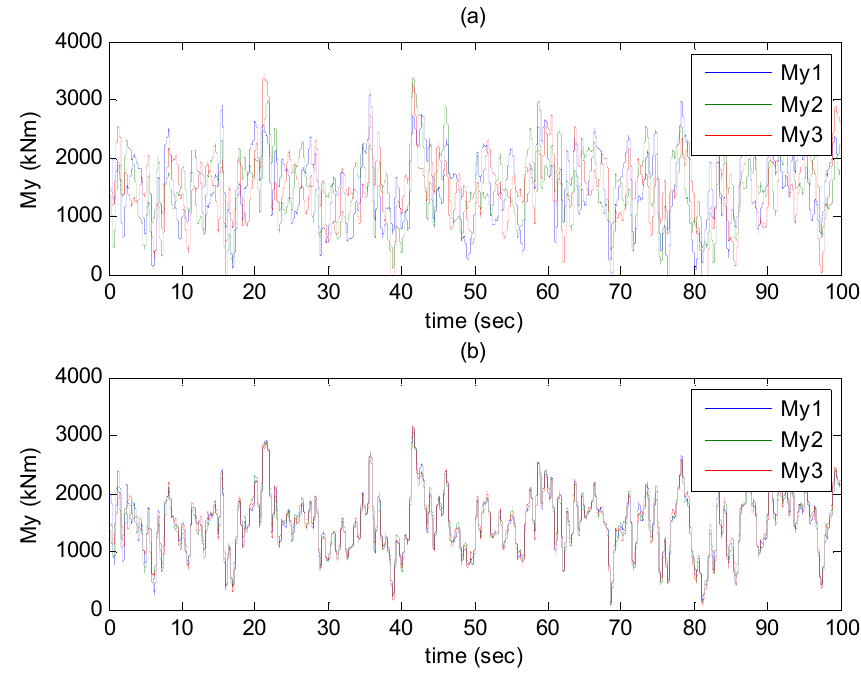
Figure 11. Responses of blade bending moments: ( a ) without IPC; ( b ) with IPC.